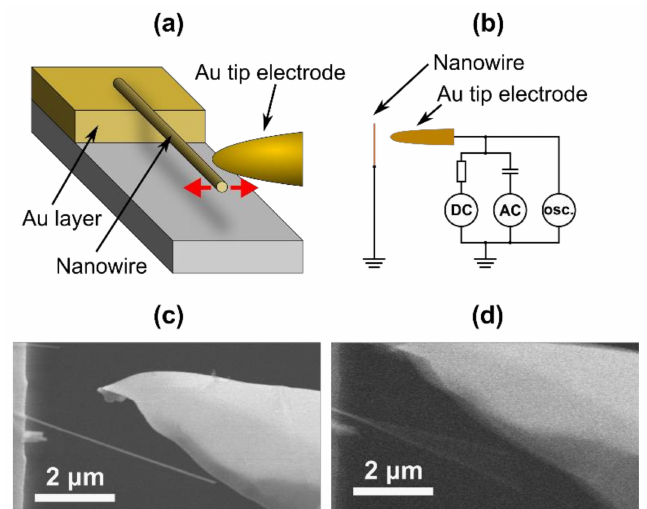
Figure 3. ( a ) Schematic of the in-situ SEM resonance test; ( b ) electric circuit during the resonance test; ( c ) CuO nanowire before resonance; ( d ) CuO nanowire during